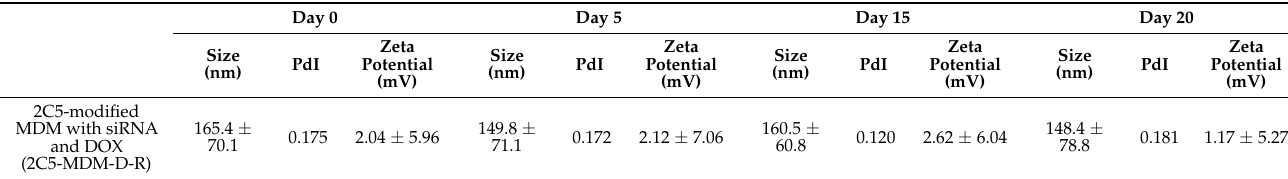
Table 1. Stability data of 2C5-modified